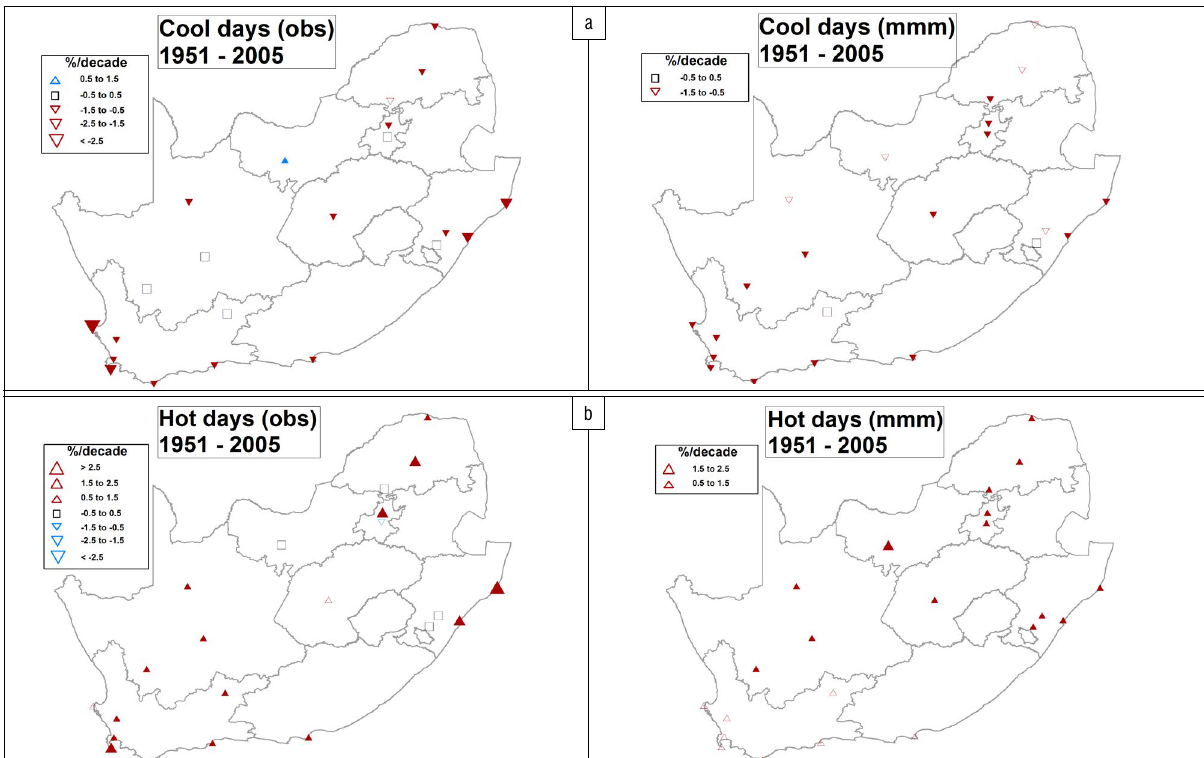
ba Figure 4: Trends in annual number of (a) cool days (TX10P) and (b) hot days (TX90P), in % per decade, for the period 1951–2005 from the observations (obs) and multi-model mean (mmm) data sets. Filled triangles denote significant trends at the 5% level. Figure 5: Trends in annual extreme minimum temperatures: (a) coldest nights (TNN) and (b) warmest nights (TNX), in °C per decade, for the period 1951– 2005 from the observations (obs) and multi-model mean (mmm) data sets. Filled triangles denote significant trends at the 5%